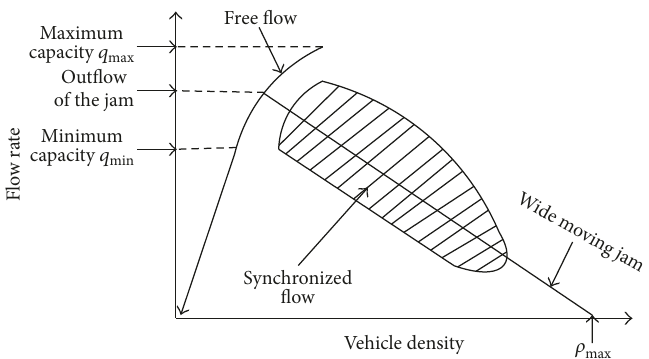
Figure 2: Three-phase traffic theory model of bottlenecks.